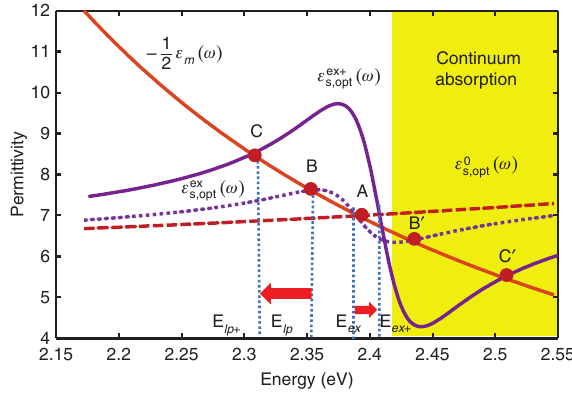
Figure 8: Classical interpretation of WEPP. Shown are the graphic solutions of Eq. (18) for the case of (A) “undressed LSP” in a semiconductor without exciton (dashed line), (B) “rigid polariton” in a semiconductor with free exciton of radius a (dotted line), and (C) “pliable” WEPP in semiconductor with 0 bound exciton of radius a < a (solid 0